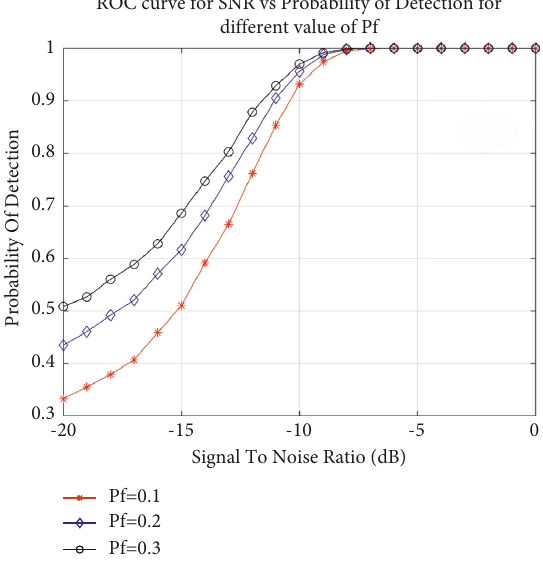
ROC curve for SNR vs Probability of Detection for different value of Pf